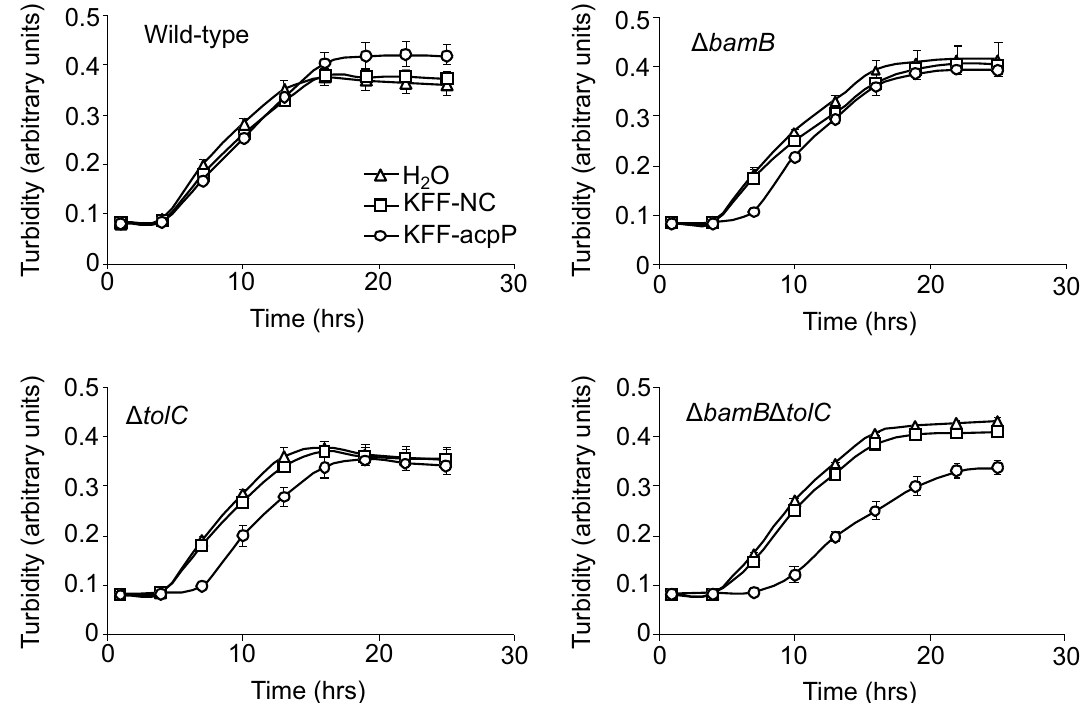
Figure 3. Growth of the wild-type and mutant strains in the presence of KFF-acpP. Cell growth in the presence or absence of CPP-PNAs is indicated. The CPP-PNAs used were KFF-NC ( □ ) and KFF-acpP ( ○ ). In a control experiment, distilled water was added instead of CPP-PNAs ( △ ). The final CPP-PNA concentration was 0.3 μM. Data are presented as the mean ± standard error of the mean from triplicate experiments. KFF-NC, negative control; KFF-acpP, CPP-PNA targeting acyl carrier